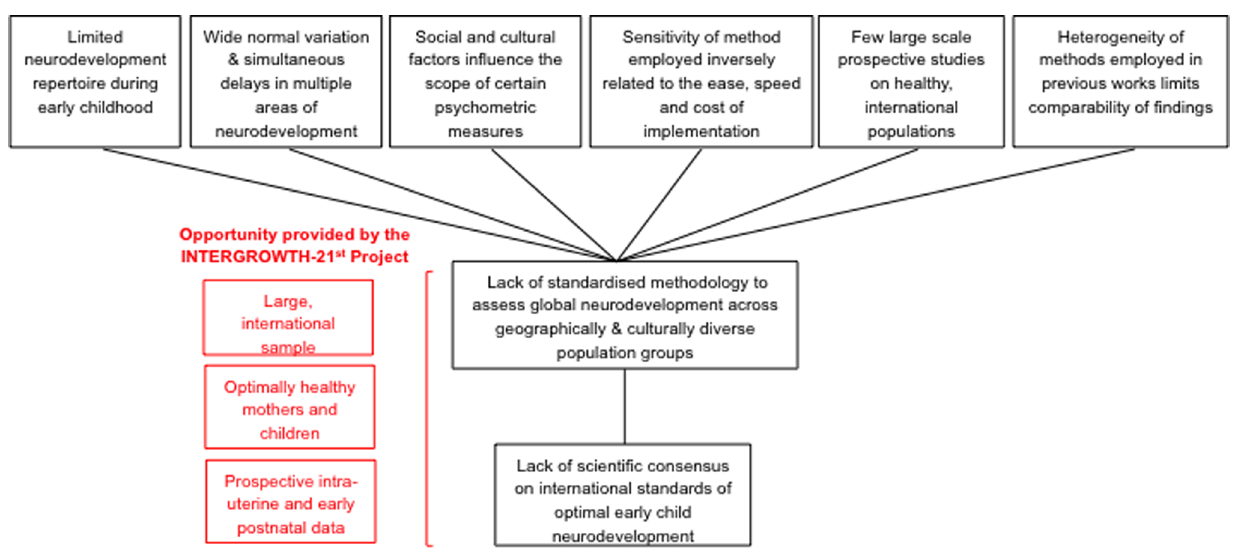
Figure 2. Conceptual and methodological challenges in the assessment of early child development in the context of the INTERGROWTH-21 st Project. Conceptual and methodological challenges in the multi-dimensional assessment of early childhood neurodevelopment across low-, middle- and high-income settings (black boxes) and the unique opportunity provided by the INTERGROWTH-21 st Project to explore some of these issues (red boxes).